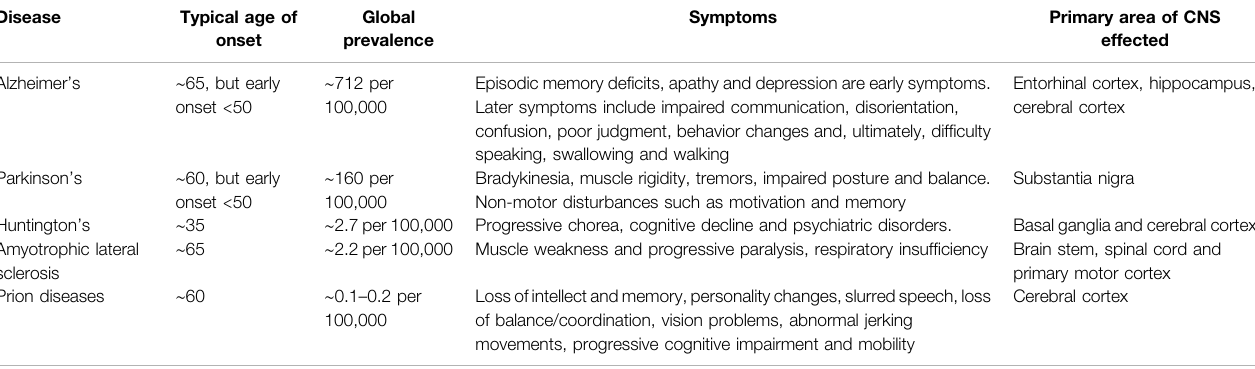
TABLE 1 | Neurodegenerative disease. Showing typical age of onset, symptoms and primary areas of central nervous system (CNS) involvement. Disease